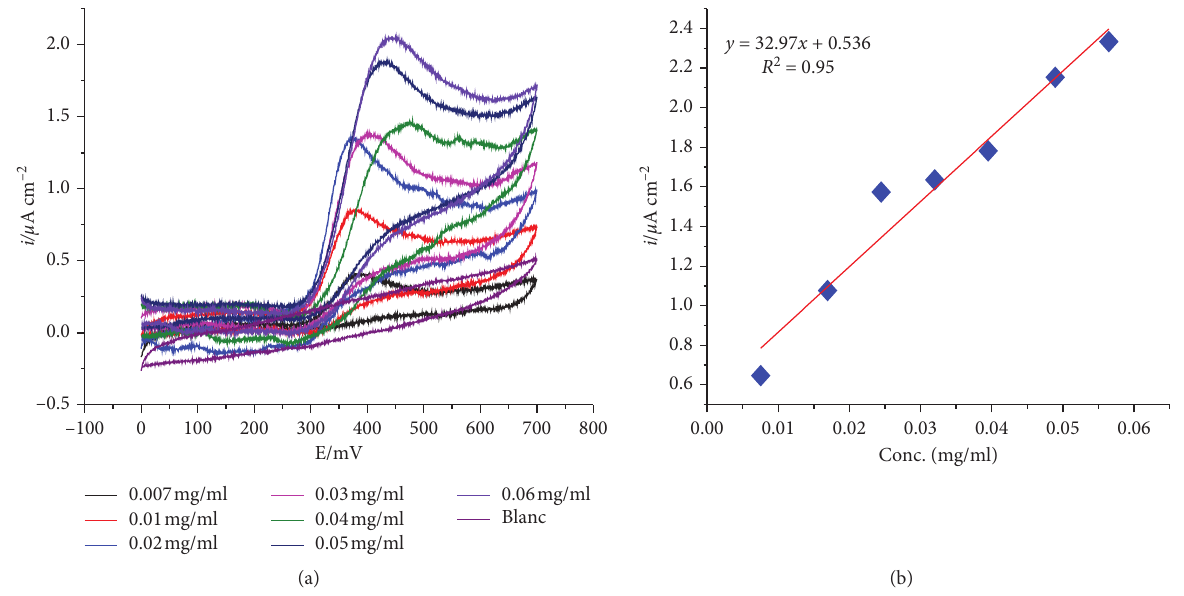
Figure 3: Cyclic voltammograms of the gallic acid solution at increasing concentrations of 0.003 to 0.06mg/ml (a). The curves of the peak anodic current (Ipa) as a function of the concentration of gallic acid (b).